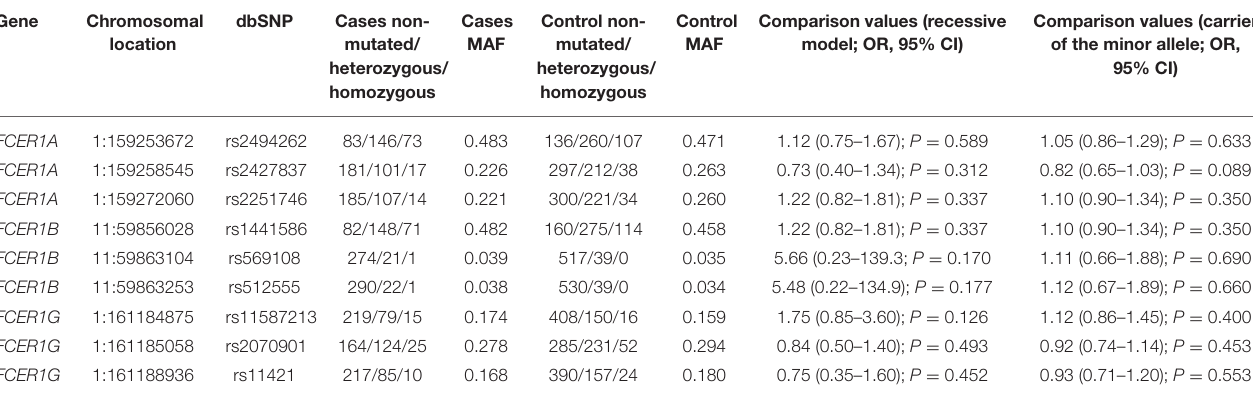
TABLE 5 | FCER1 SNPs analyzed in this